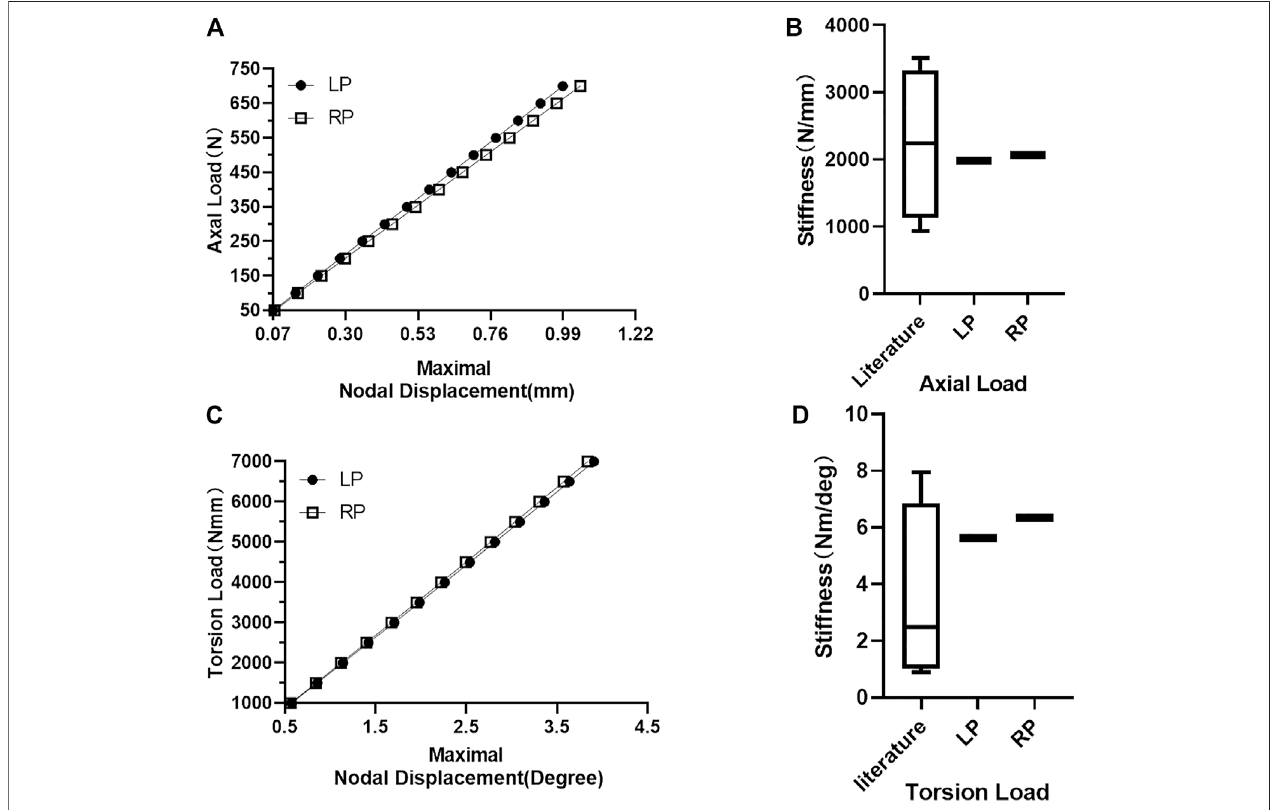
FIGURE4| Maximumnodedisplacementandconstructstiffness. (A) Constructs ’ maximumnodaldisplacementincreaseswithloadunderaxialcompressionload conditions. (B) Comparison of LP and RP construct axial compression stiffness with the stiffness values reported in the literature. (C) Constructs ’ maximum nodal displacement increases withload under torsional load conditions. (D) Comparison ofthetorsionalstiffness ofLP and RPconstruct withthe stiffness ofprevious studies.